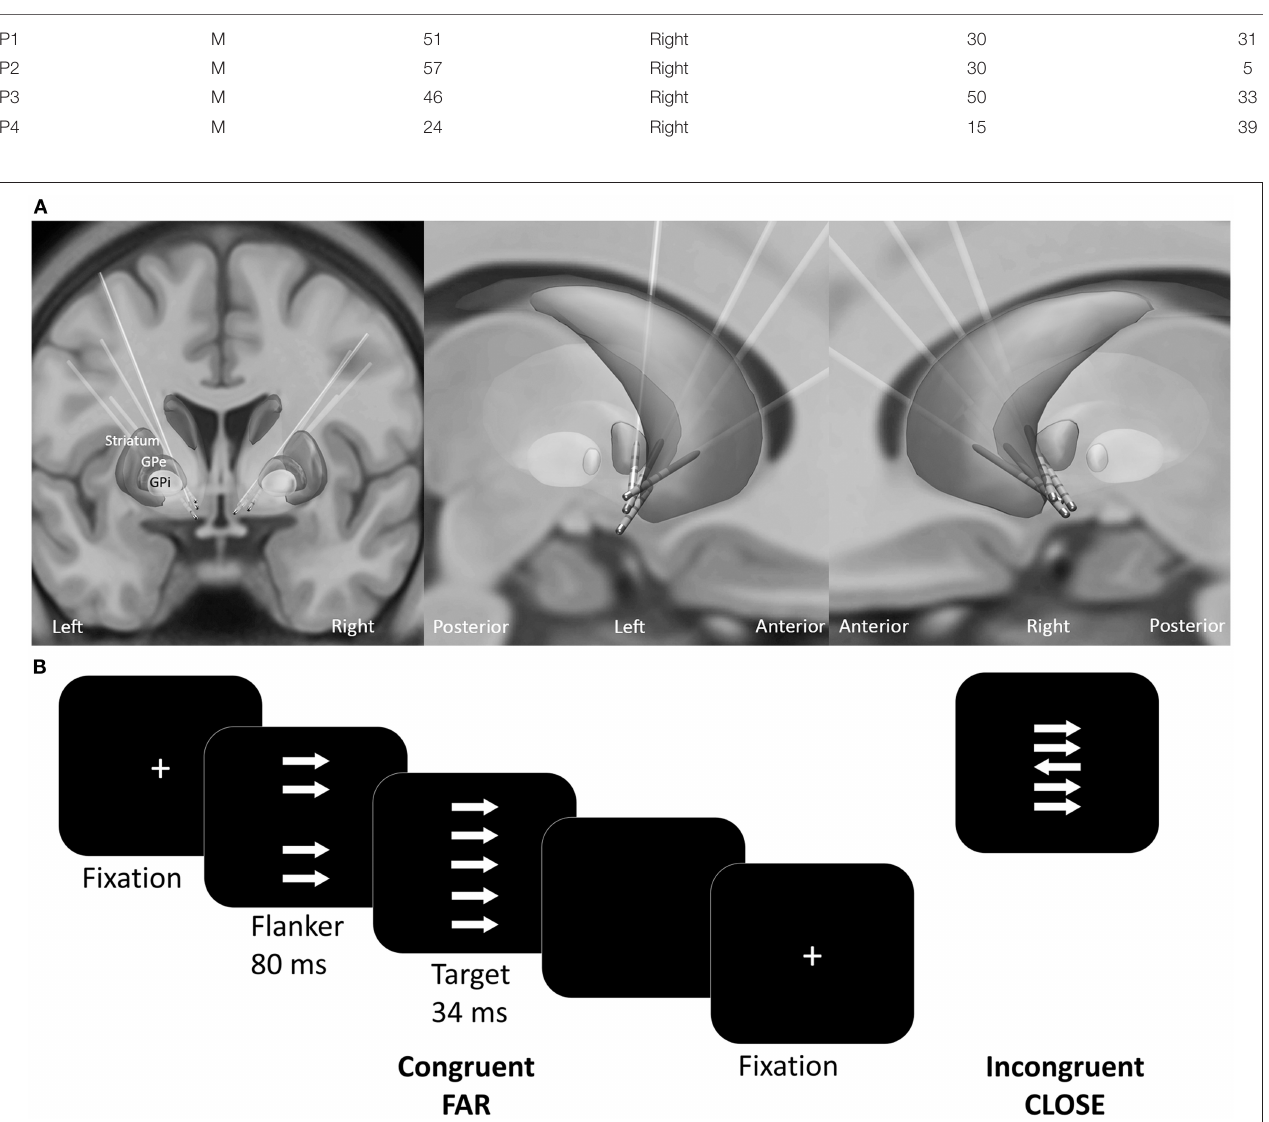
FIGURE 1 | (A) Reconstructed electrode location of all patients in MNI space. (B) Experimental design of the custom version of the Erikson Flanker task. Patients had to respond accordingly to the target arrow orientation with a button press. The conditions varied regarding the congruency (congruent, incongruent) and distance (far, close) between the target arrow and the